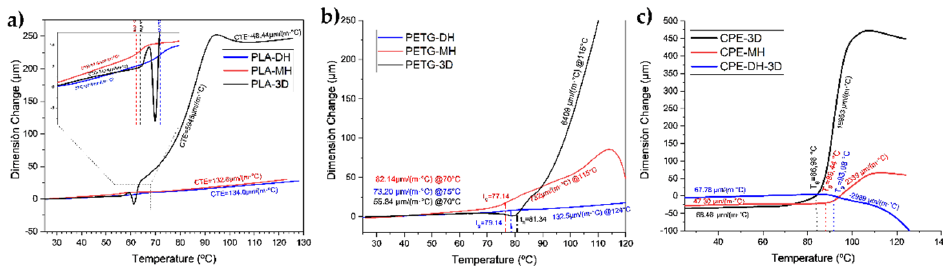
Figure 12. TMA curves of 3D printed ( a ) PLA, ( b ) PETG, and ( c ) CPE ‐ based samples, before and after both sterilization